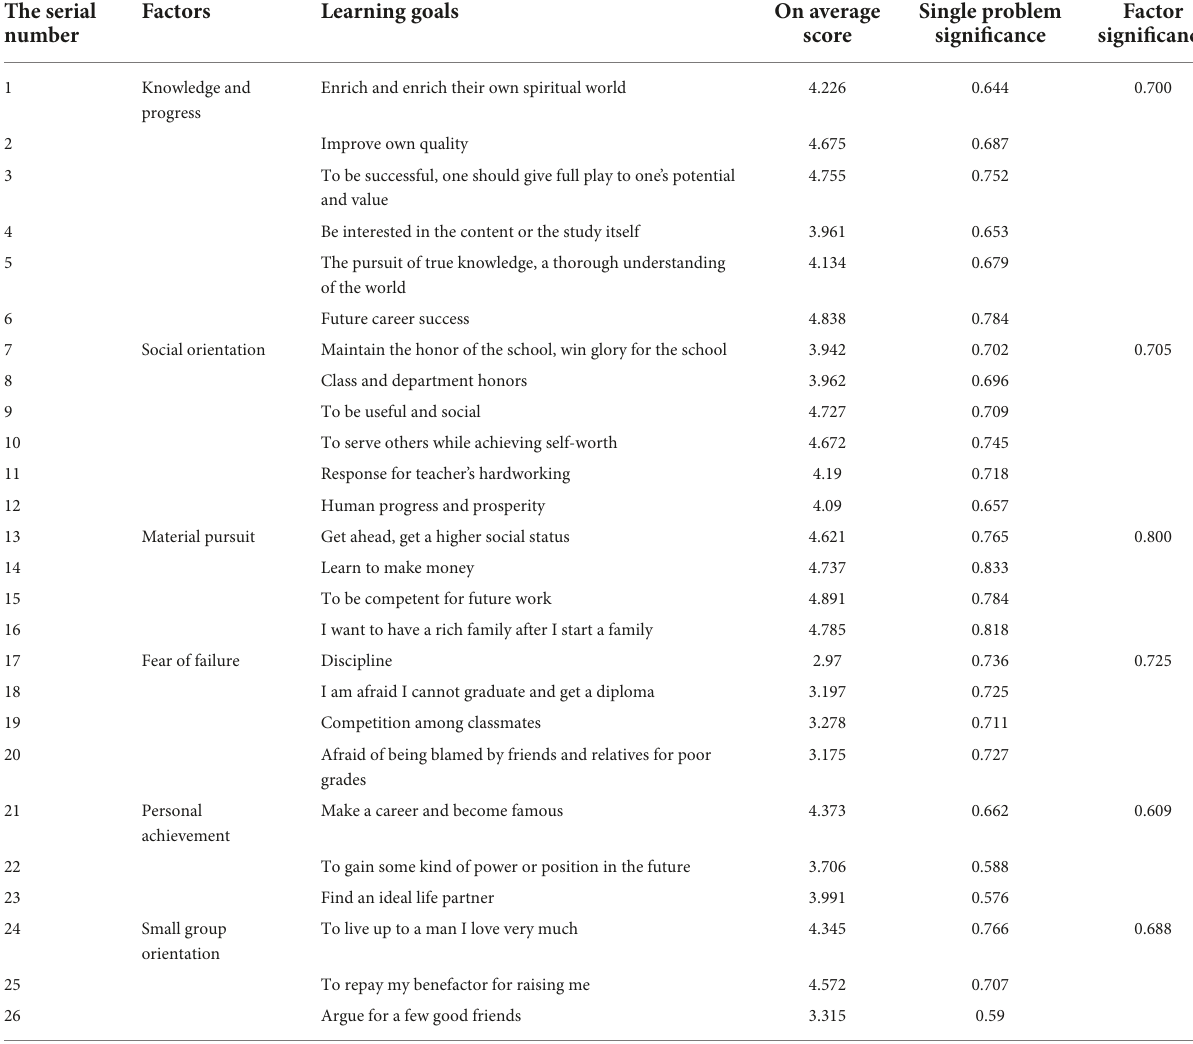
TABLE 1 Mean scores of the six motivations of the respondents and their significance in learning motivation.